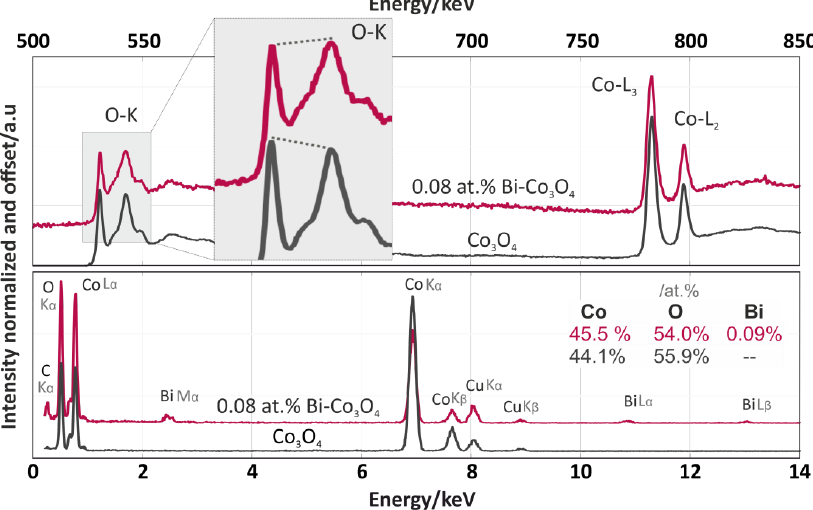
Figure 6. Electron energy-loss spectroscopy (EELS) (upper part) and energy-dispersive X-ray spectroscopy (EDX) (bottom part) spectra of the Co 3 O 4 (grey) and 6.6 wt % Bi-Co 3 O 4 (pink) catalysts.